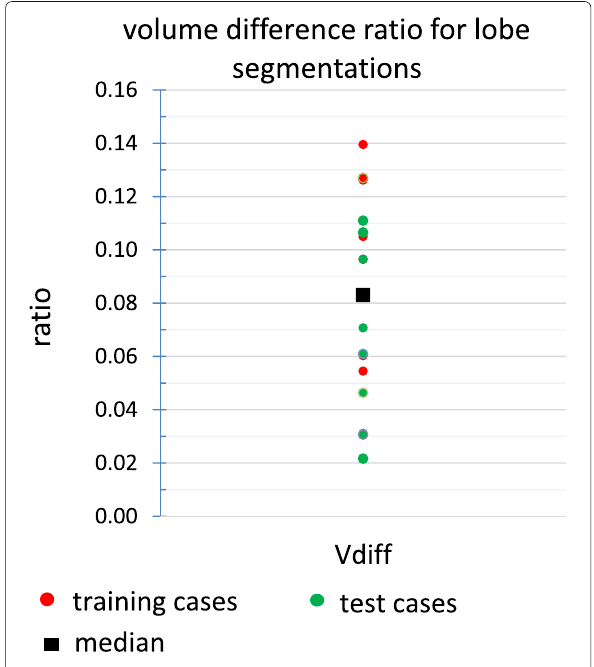
Fig. 12 Volume difference parameter. The liver volume which was assigned to different lobes by standard venous anatomical (using CT) and perfusion (on CBCT) lobe segmentation for both training and test cases